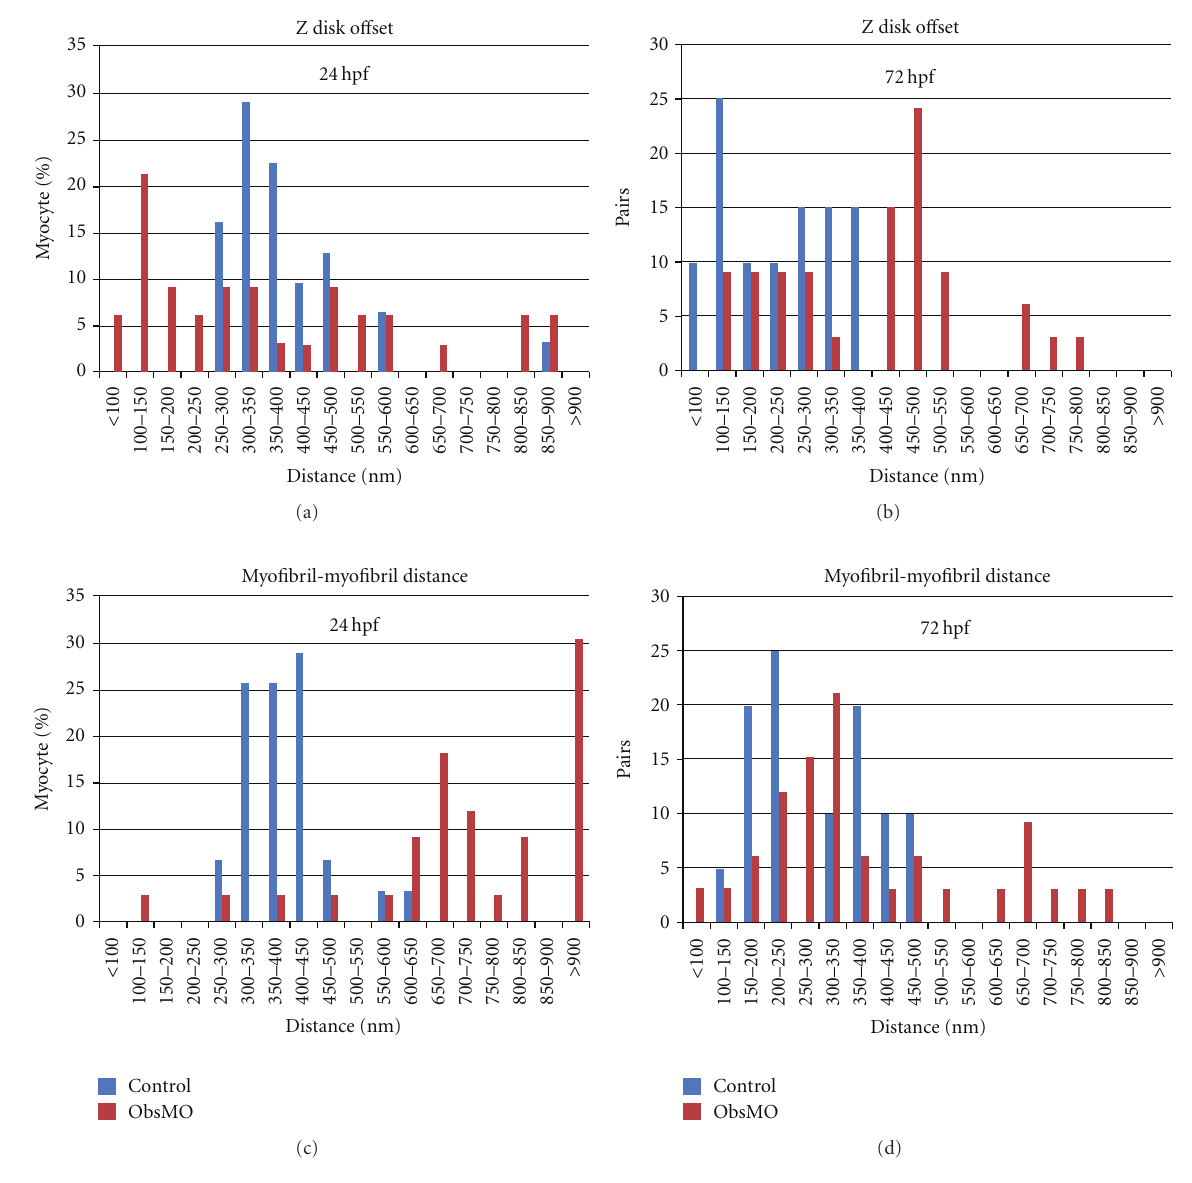
Figure 10: Obscurin depletion results in greater variability in the relationship between superficial myofibrils in adjacent myocytes. (a) At 24hpf, obscurin morphant embryos (red bars) demonstrate a greater variability in Z disk alignment than control embryos (blue bars). Note that in the majority of myocyte pairs evaluated, the superficial myofibrils demonstrate a Z disk o ff set of approximately 250–500 nm in control embryos. (b) By 72 hpf, the Z disk o ff set has been significantly reduced in control embryos but was still quite variable in obscurin morphant embryos. (c) Similarly, at 24 hpf in control embryos (blue bars), there was a consistent distance between the superficial myofibrils in adjacent myocytes. However, in obscurin morphant embryos, the distance is significantly greater and more variable. (d) By 72 hpf, the distance between superficial myofibrils has been reduced in control and obscurin morphant embryos but remains more variable in the obscurin